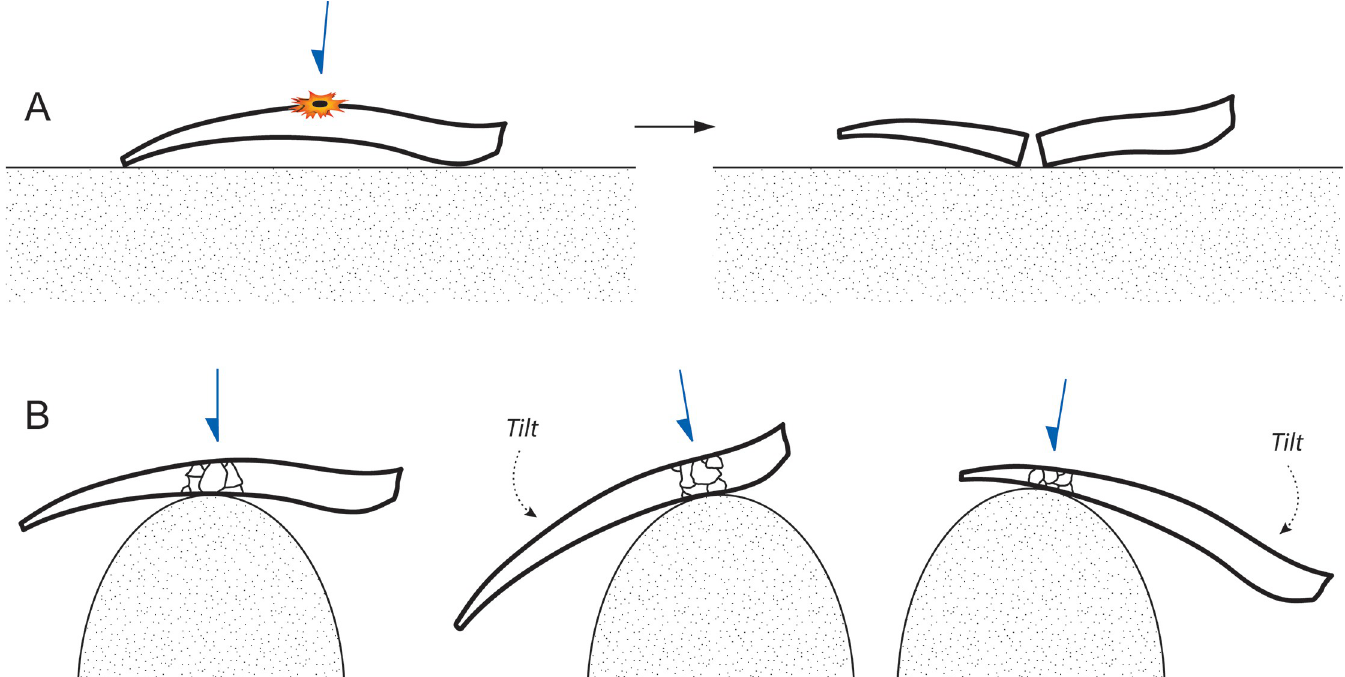
Fig 28. Technical issues in microlith backing, Horizon IV, Saruq al-Hadid. The schematic drawing shows the side view of a flake blank and anvil surface. (A) If a flake blank is placed on a flat anvil, there is a risk that the blank’s curvature will cause it to be unsupported opposite the point of force application (PFA), and backing can fail through a bending fracture. (B) Effective backing occurs when the blank is properly supported opposite the PFA. A convex surface allows the flintknapper to maintain anvil contact regardless of the degree of flake blank curvature, by tilting the blank as backing progresses.